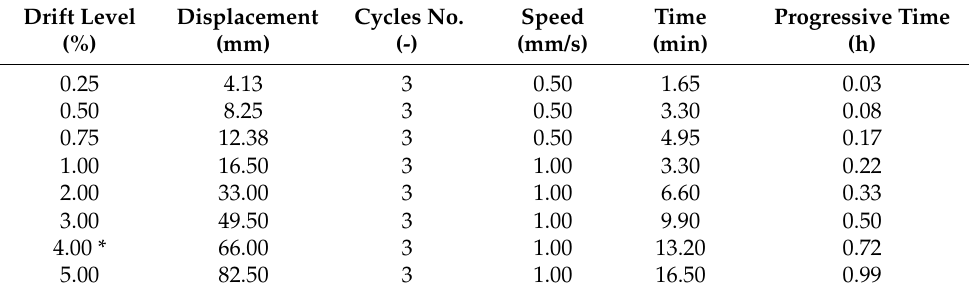
Table 2. Designed test protocol—circular pier.